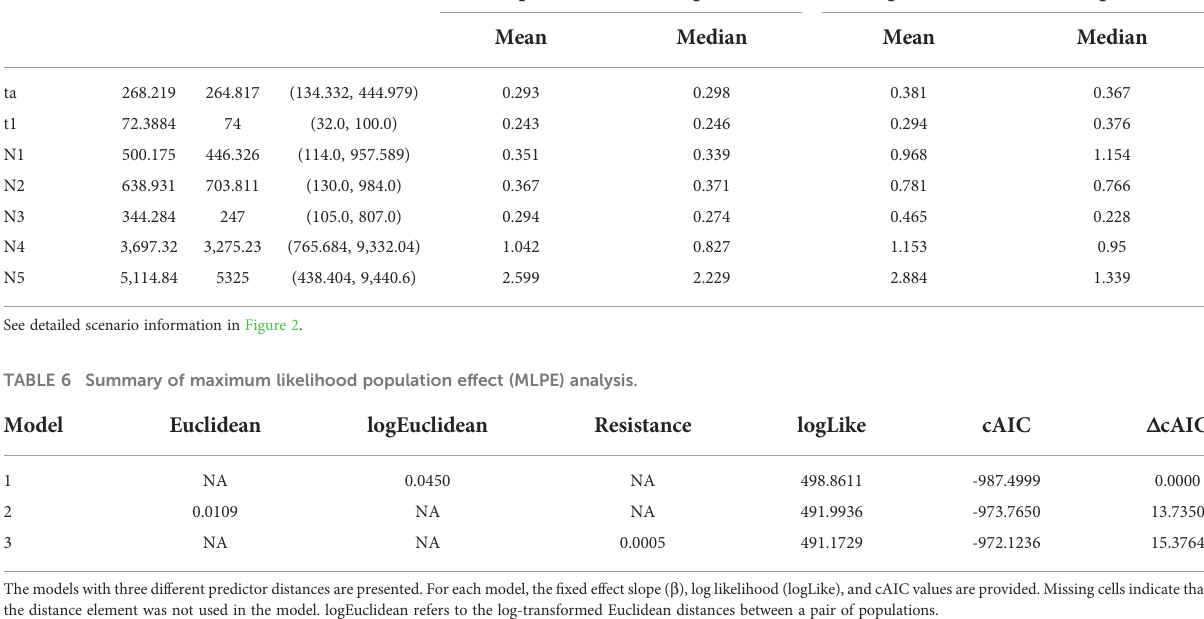
TABLE 5 Summary results of DIYABC-rf parameter estimation under scenario 7. Parameter Mean